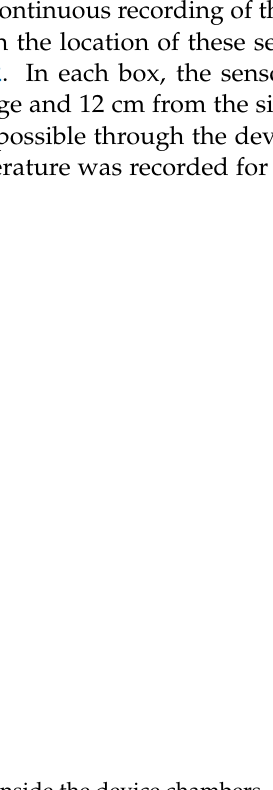
Figure 2. Arrangement of temperature sensors inside the device chambers, and dimensions in mm .